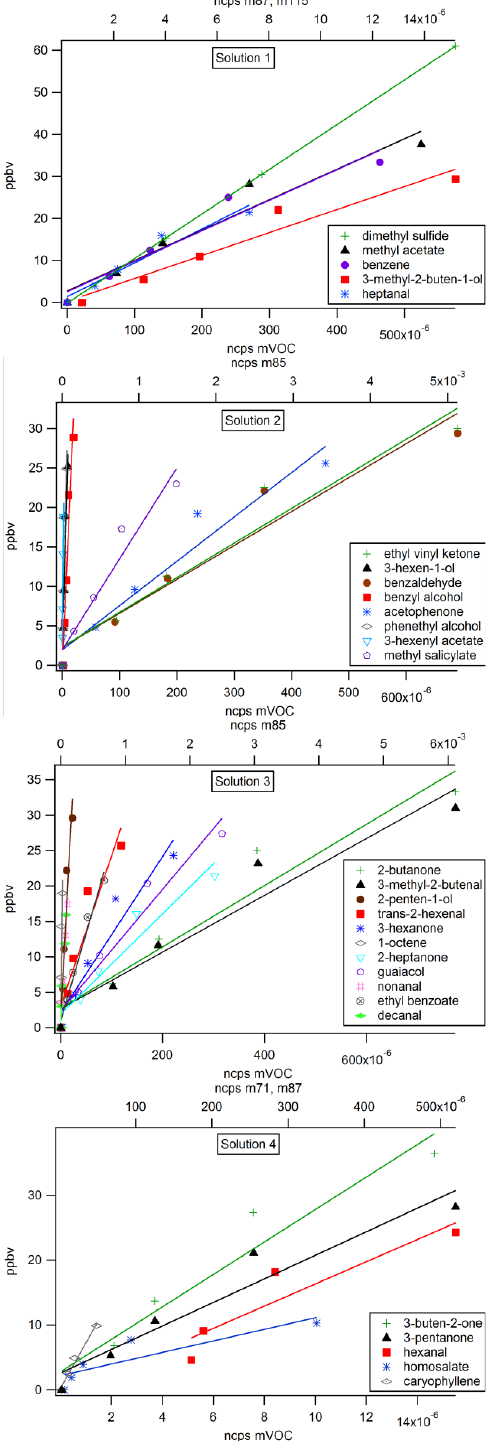
Fig. 3. Calibration of the PTR-MS to 30 different compounds in 4 different cyclohexane solutions using the DSI technique. VOC concentrations generated by the DSI system are plotted versus normalized counts per second (ncps).